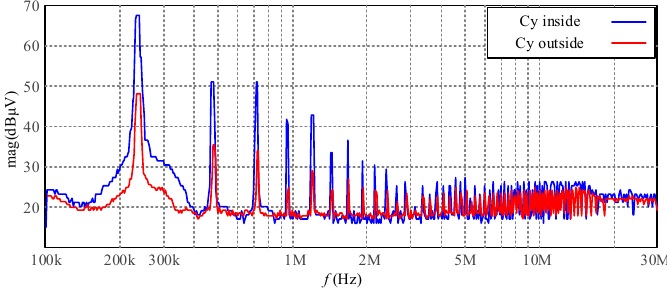
Figure 4. CM emission curves when C Y at inside/outside.